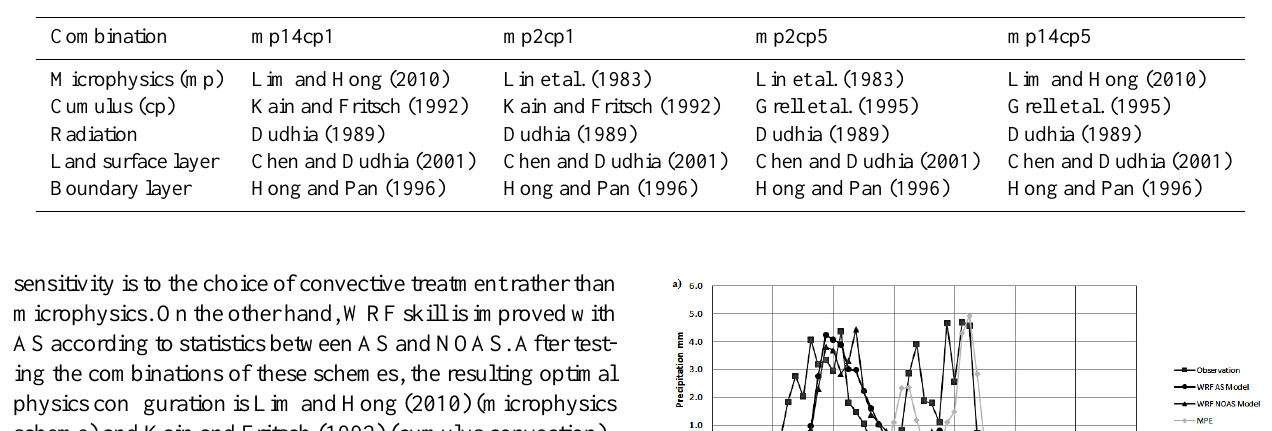
Fig. 3. Bias, RMSE, and false alarm rate (FAR) are shown in (a) , (b) , and (c) , respectively, for different microphysics and cumulus options when WRF model is simulated with assimilation (AS) and without assimilation (NOAS) on 12–17 July 2009. Table 3. Combinations of microphysics and cumulus parameterizations for optimal configuration as well as other physics used in the WRF model. mp and cp stand for microphysics and cumulus schemes, respectively, which are used with options 2 and 14 for mp and 1 and 5 for cp available in WRF model.